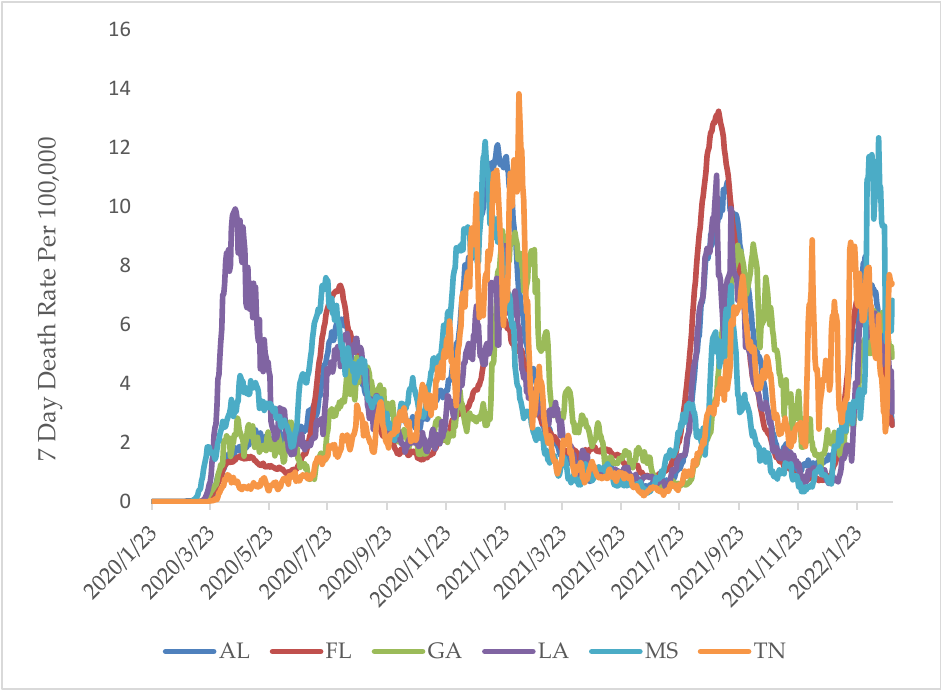
Figure 5. Time series analysis showing COVID-19 death rate change over time in the selected states from January 2020 through February 2022. Table 1. Rates of COVID-19 cases and death rates by sex in the selected